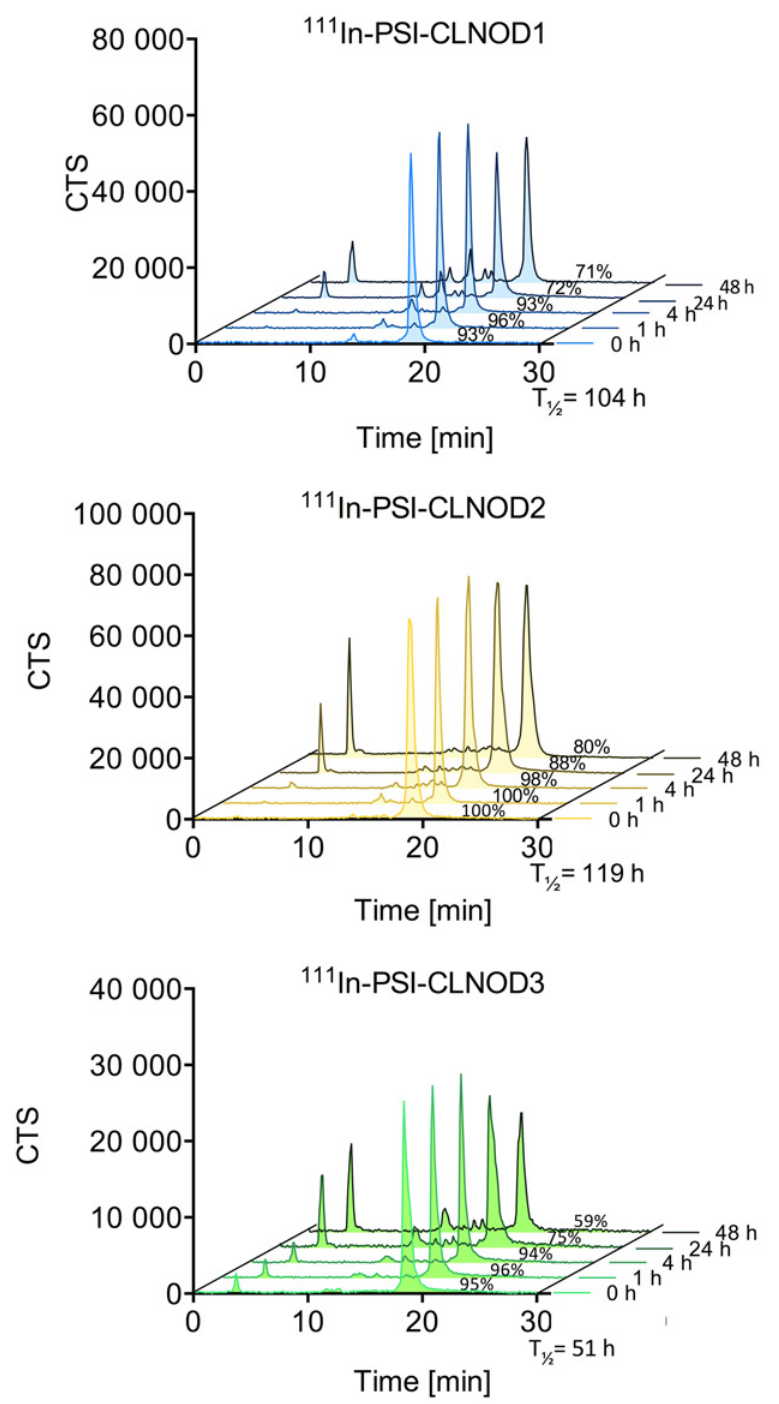
Fig 4. Plasma stability of 111 In-labelled PSI-CLNOD1, PSI-CLNOD2 and PSI-CLNOD3 in fresh human blood plasma.